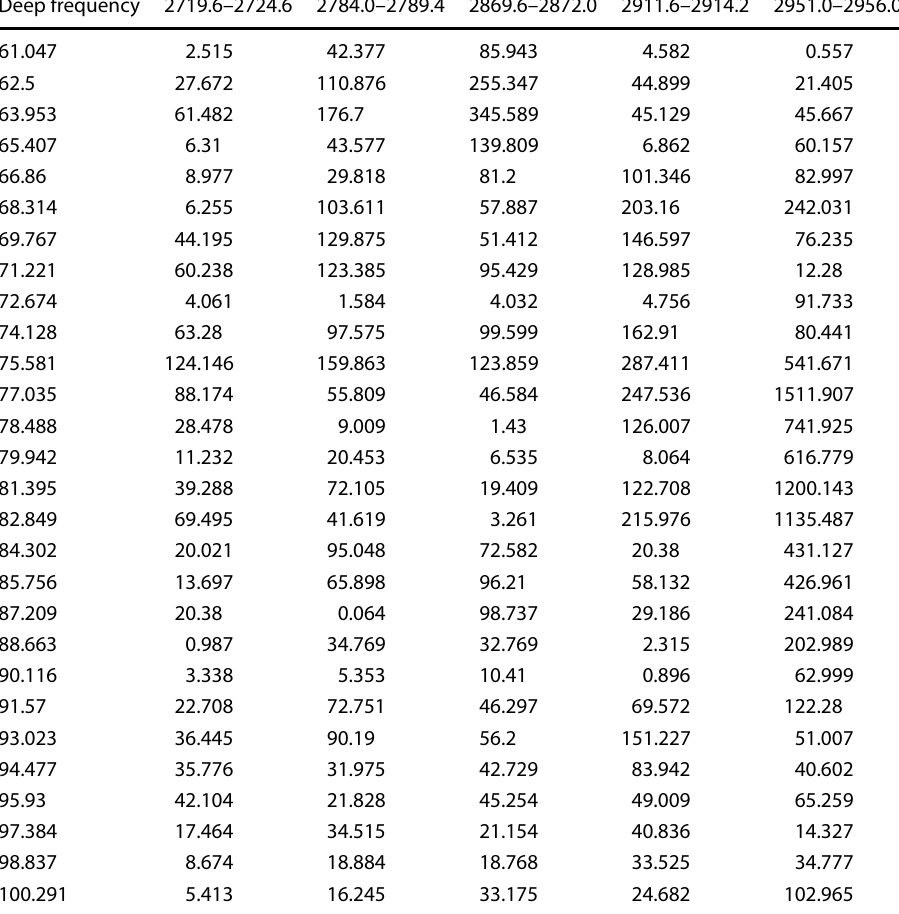
Table 2 Pre-processed